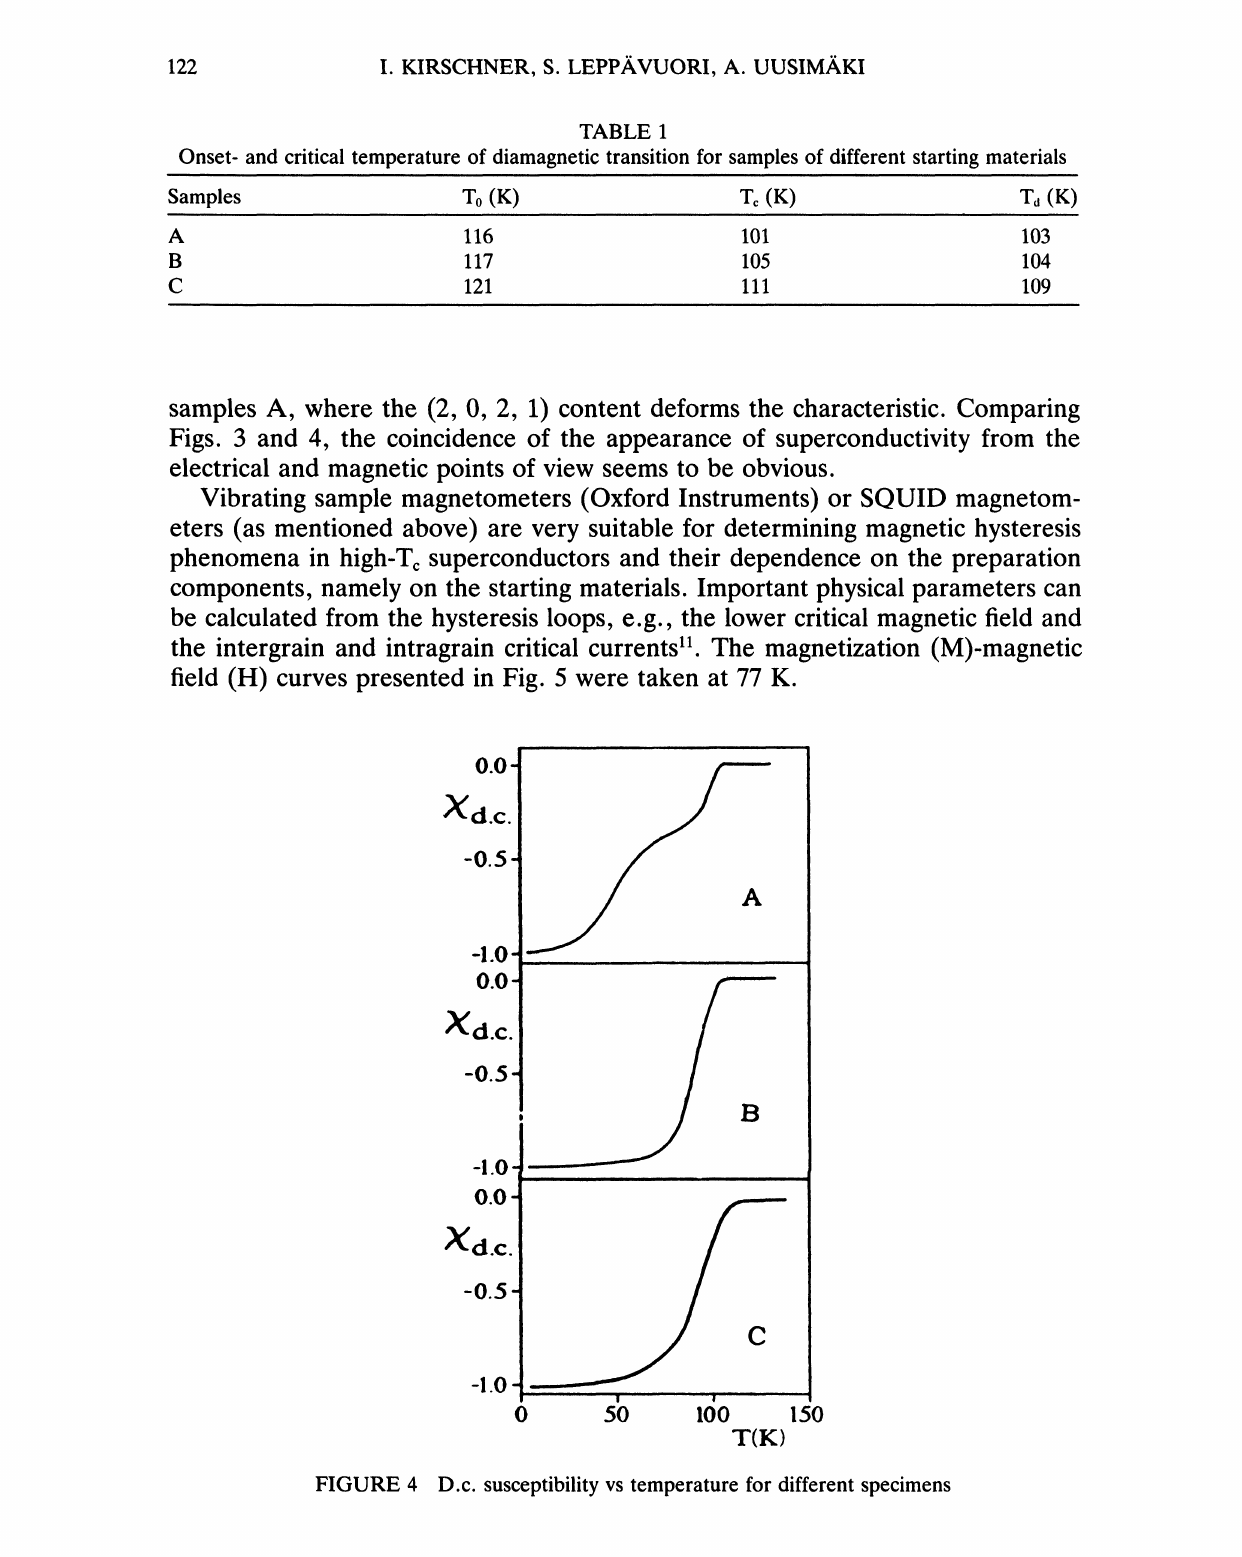
TABLE Onset- and critical temperature of diamagnetic transition for samples of different starting materials